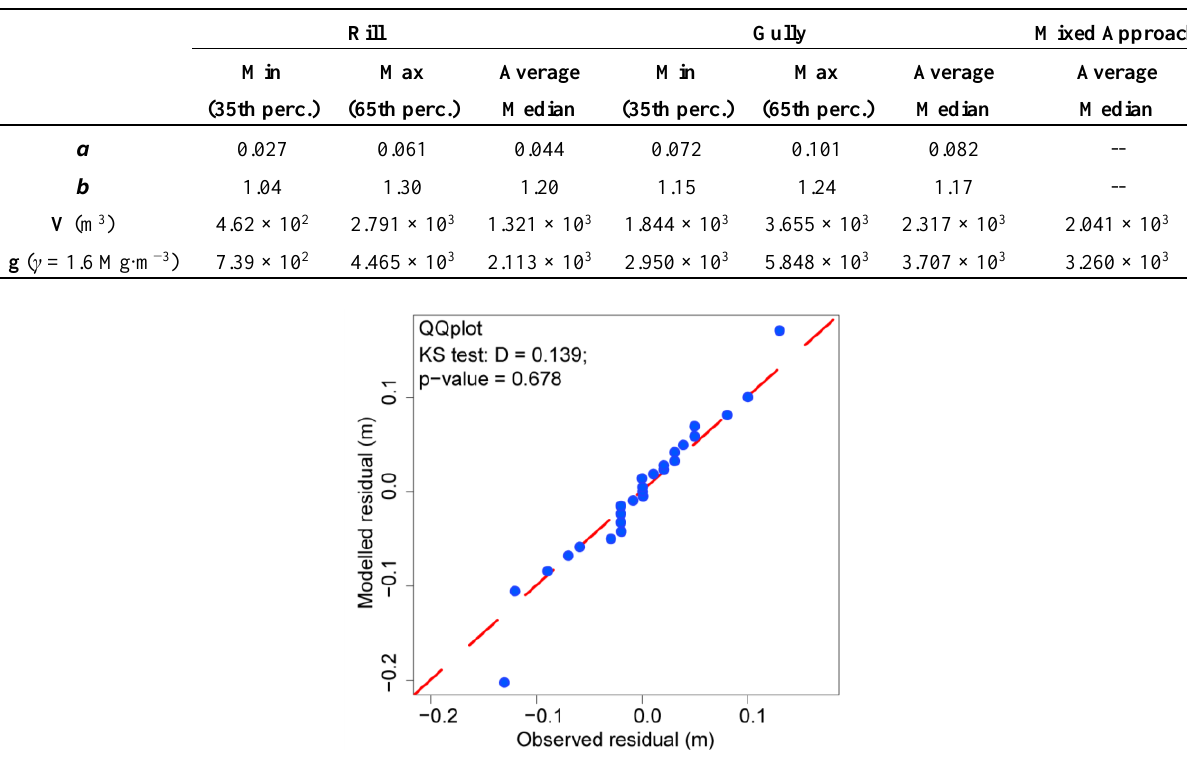
Figure 13. Kolmogorov-Smirnov test (KS) and the quantile-quantile (QQ) plot of the modelled and measured